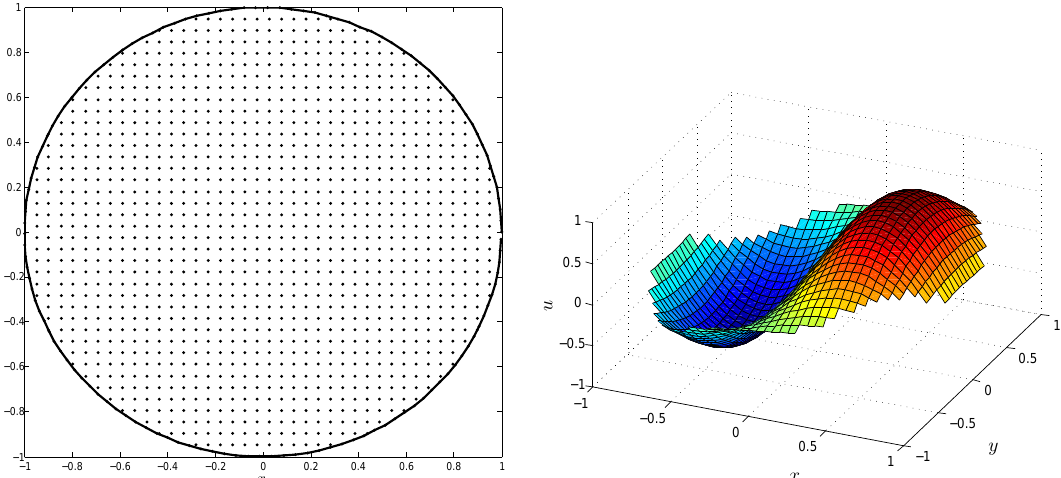
Figure 8. Computational circle domain x -axis [ − 3,3 ] and y -axis [ − 3,3 ] ( left ) and numerical solution ( right ) for Problem 2.